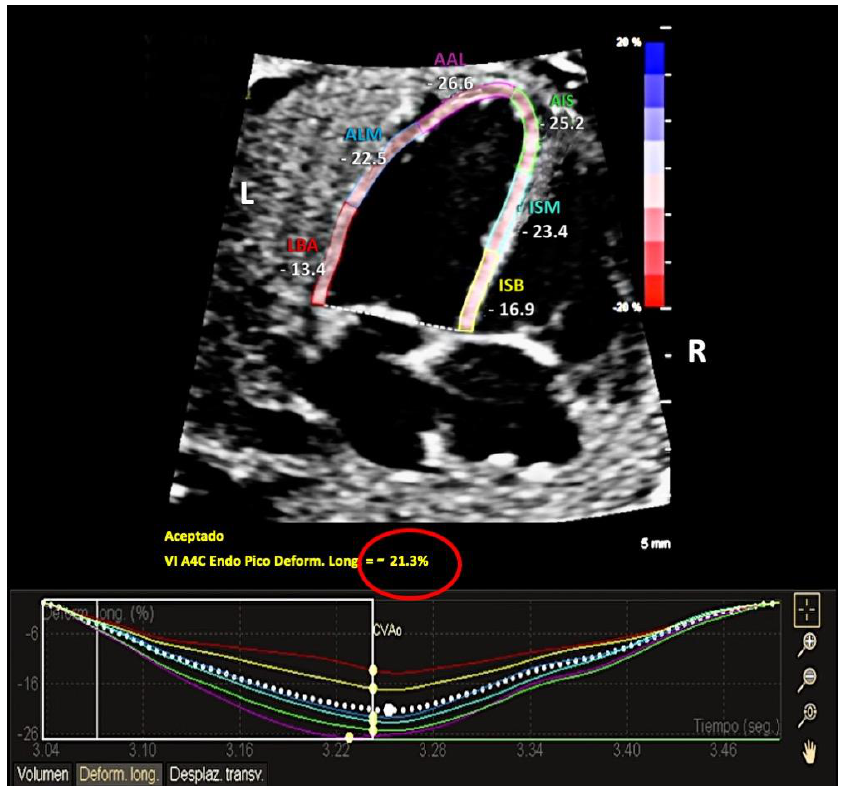
Figure 1. Strain analysis with aCMQ-QLab by Philips. The software automatically delineated the left-ventricular myocardium, providing left-ventricle global longitudinal strain (red circle), as well as individual segment measurements; from left to right: basal segment of left-ventricle wall (LBA), middle segment of left-ventricle wall (ALM), apical segment of left-ventricle wall (AAL), basal interventricular septum (ISB), middle interventricular septum (ISM), and apical interventricular septum (AIS). L, left; R, right. Abbreviations differ from the manuscript, due to software language (Spanish).